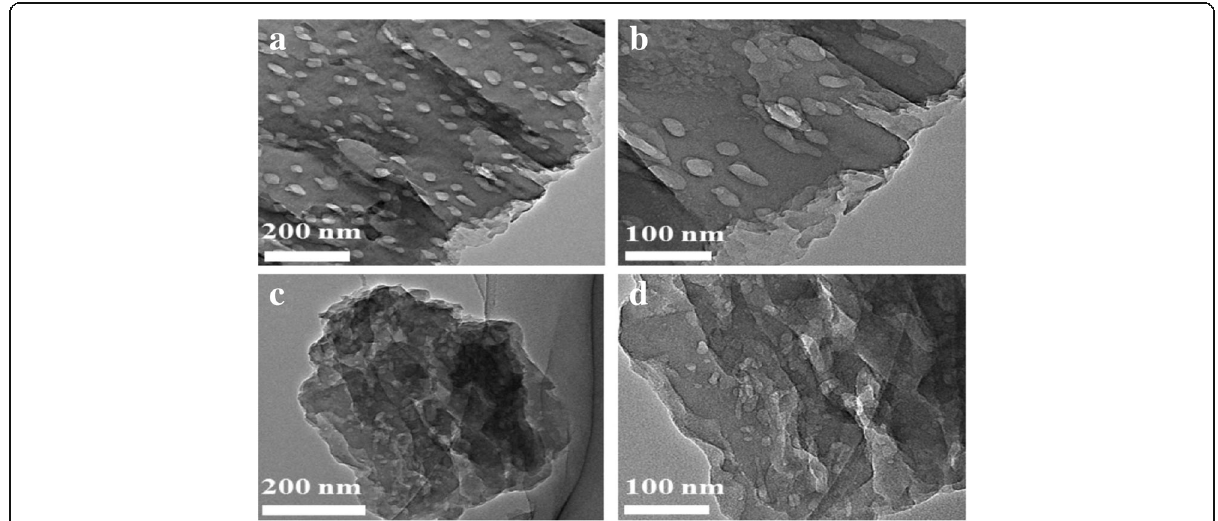
Fig. 4 TEM images of TCN ( a and b ) and MCN ( c and d ) using a hard templating approach. Reproduced with permission from [120]. Copyright 2015. Elsevier